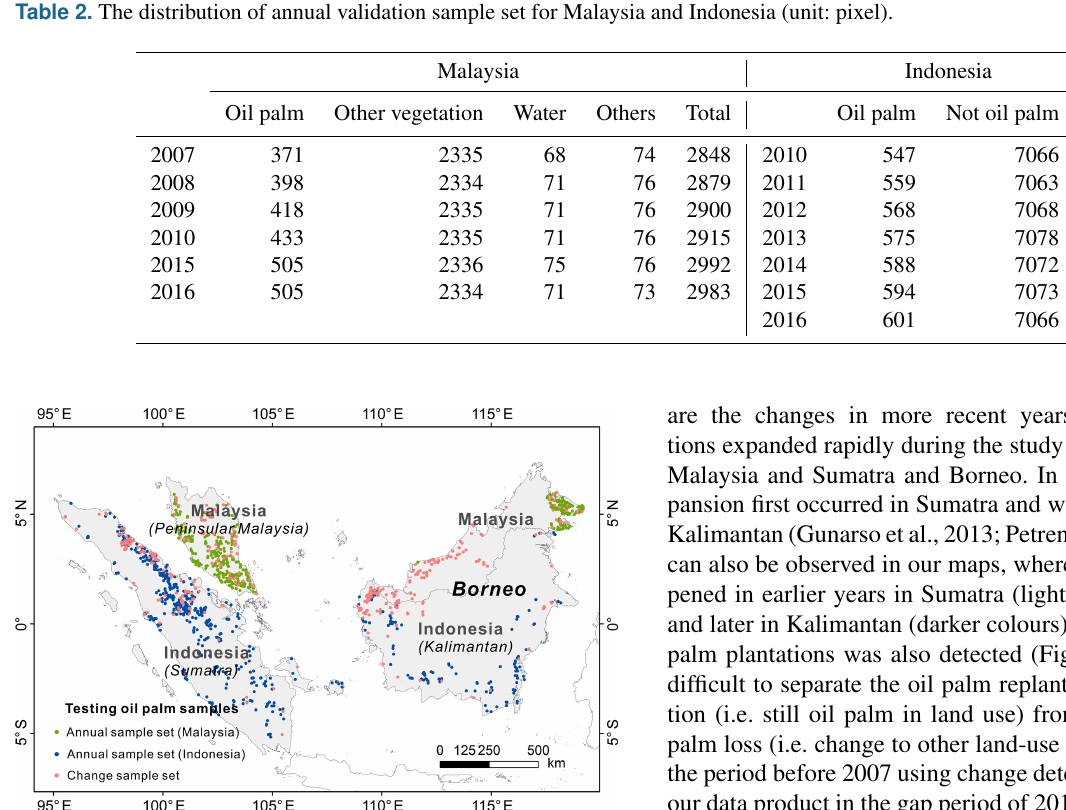
Table 2. The distribution of annual validation sample set for Malaysia and Indonesia (unit: pixel).